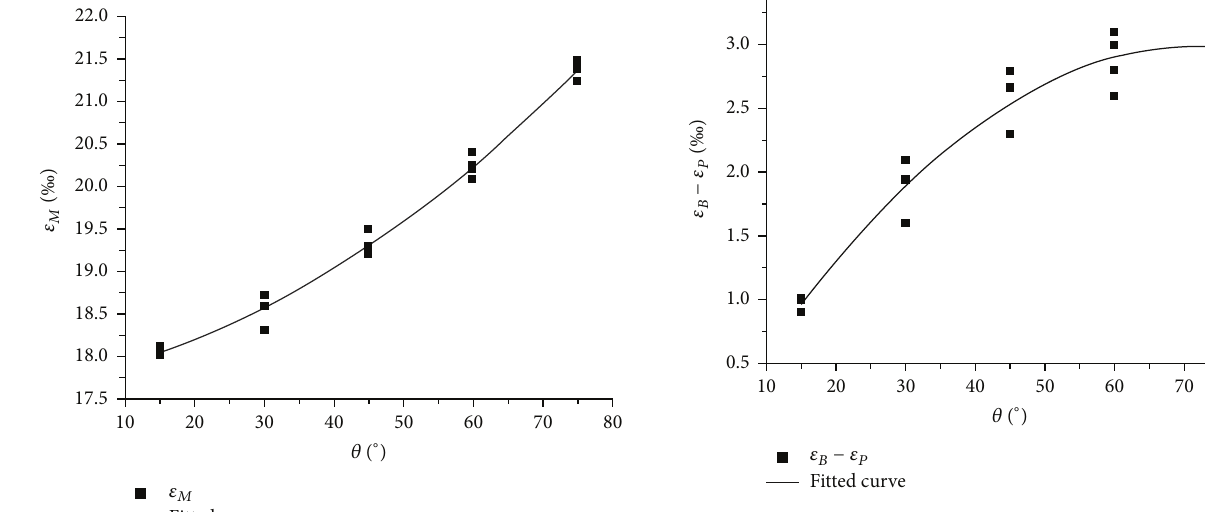
Figure 15: Unloading deformation versus crack